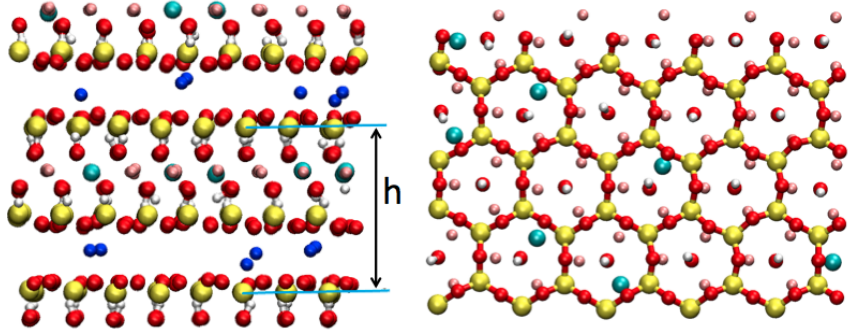
Figure 1. On the left: view of the hectorite sheets as simulated. h is the layer-to-layer distance. On the right: View of the surface of an hectorite sheet simulated with Polarizable Ion Model (PIM). Yellow: Si; Red: O; White: H; Pink: Mg; light blue: Li.; Dark blue: